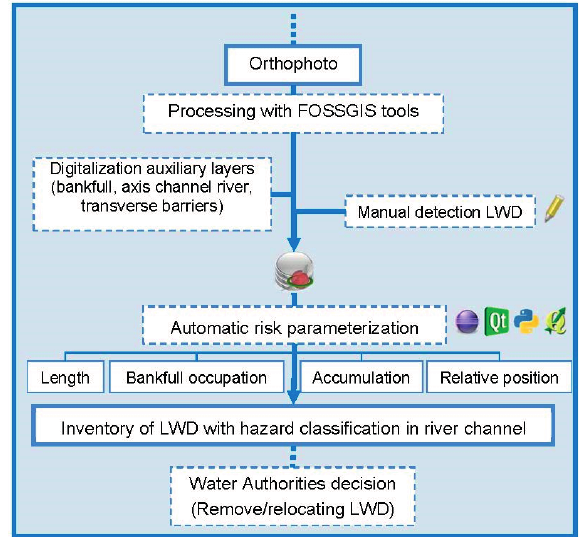
Figure 4. Flowchart of the processing with FOSSGIS tools for obtaining an inventory of LWD with hazard classification in the river channel (dashed line: flux or process; continuous line: data and generated products).